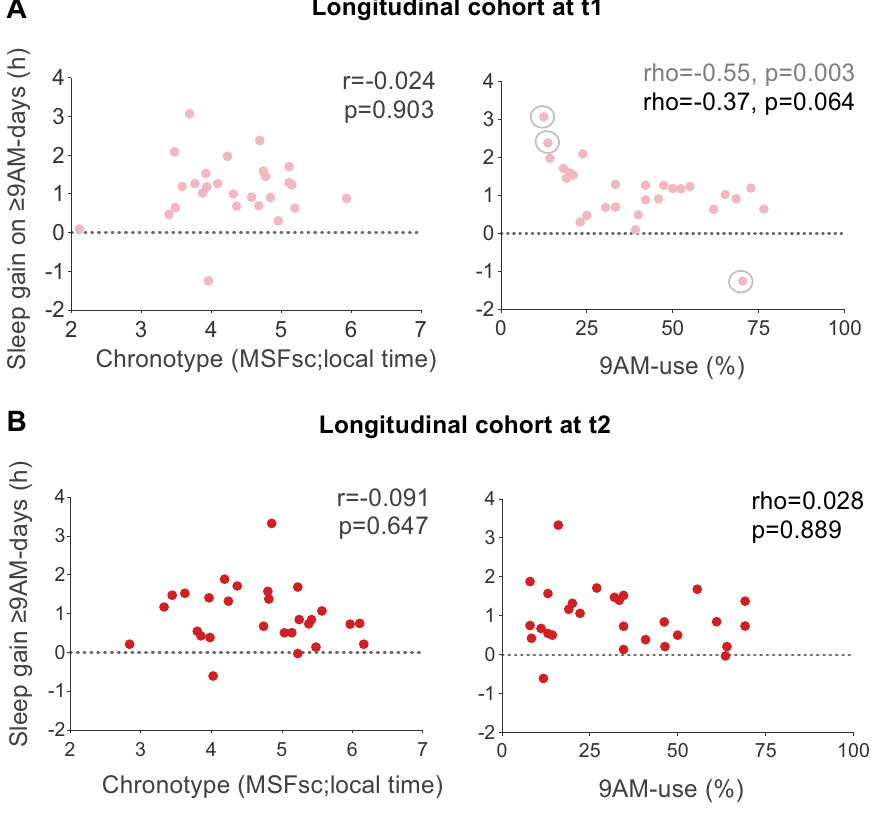
Figure 4. Inter-individual differences in sleep gain on ≥ 9AM-days. Shown are relationships between chronotype (MSF sc ; local time) or frequency of ≥ 9AM-starts (% of schooldays with later starts) with sleep gain on ≥ 9AM-days. Sleep gain was quantified as the absolute difference in sleep duration between ≥ 9AM and 8AM-days, with positive numbers indicating longer sleep duration on ≥ 9AM-days. Data are from the longitudinal cohort (n = 28) during ( A ), t1 (light red) and ( B ), t2 (red). Results of Pearson (r) and Spearman (rho) correlations are indicated. Tukey outliers in sleep gain, which over-proportionally influence the correlation with 9AM-use at t1 (right panel in A ), are marked with grey empty circles, and correlation results including (grey) and excluding outliers (black) are